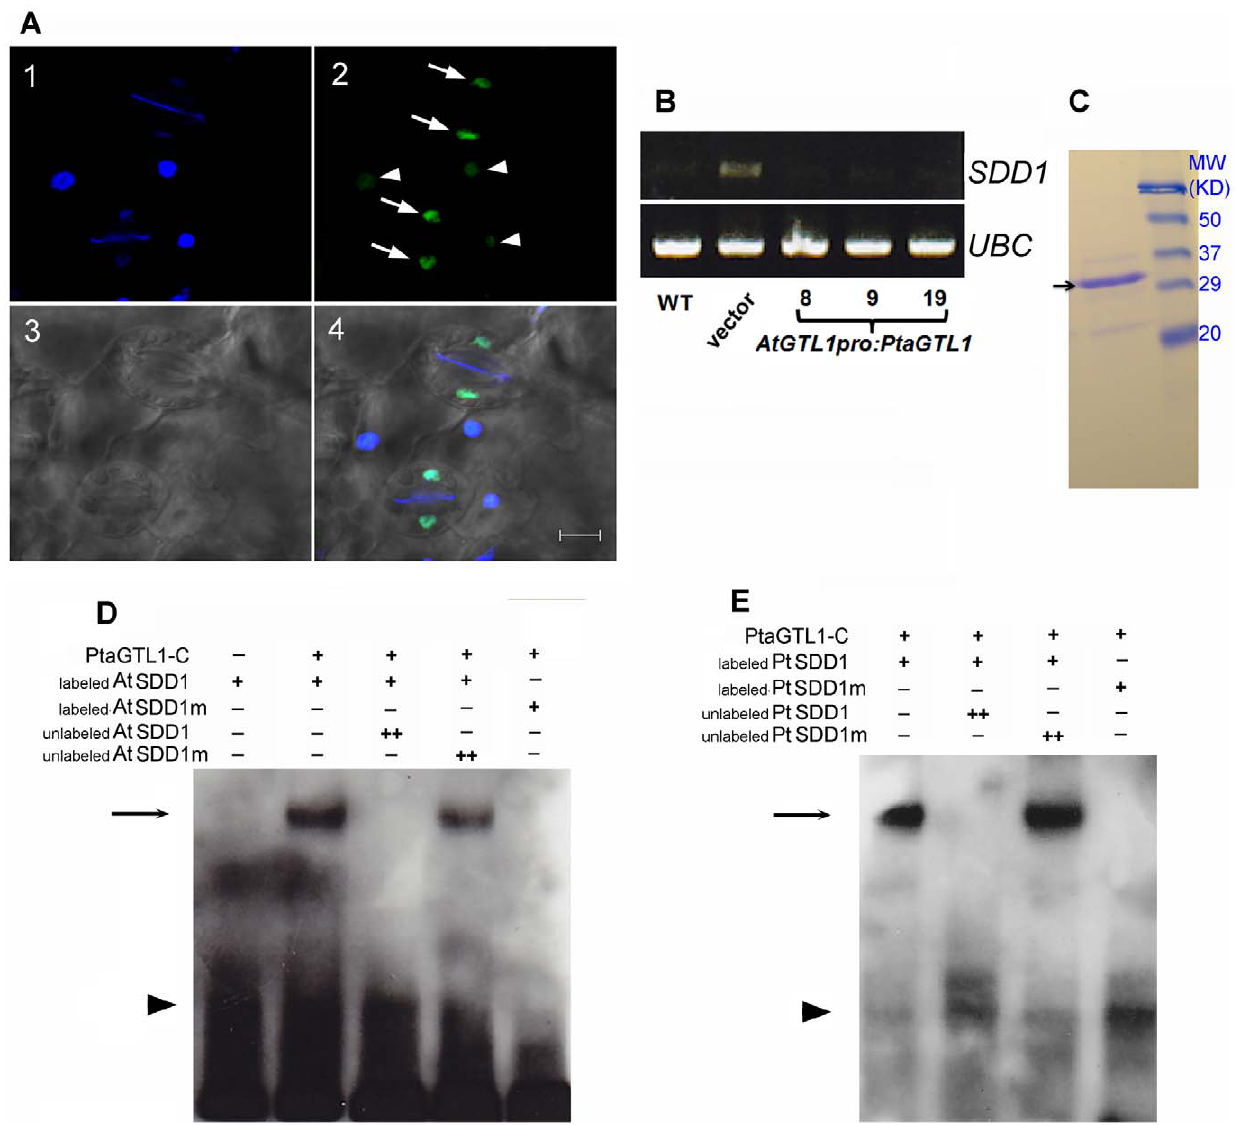
Figure 4. PtaGTL1 is localized to the nucleus, binds to a GT3 box-containing AtSDD1 promoter fragment, and trans-represses AtSDD1 expression. A. An abaxial epidermal layer of a one-week-old seedling leaf from a transgenic gtl1-4 plant expressing AtGTL1pro:PtaGTL1-GFP (line 9) was photographed with a confocal laser scanning microscope. Nuclei of guard cells (arrows) and pavement cells (arrowheads) were stained with DAPI (4 9 ,6-diamidino-2-phenylindole). 1, DAPI fluorescence, showing nuclear location; 2, GFP fluorescence, showing PtaGTL1 localization; 3, Light microscopic picture of the corresponding cells; 4, Panels 1, 2, and 3 merged. Bar equals 10 m m. B. SDD1 expression in fully expanded rosette leaves from 5-week-old plants (12-h diurnal photoperiod) was determined by RT-PCR. UBC was used as an internal control. C. Two micrograms of affinity purified 6 6 His-PtaGTL1-C was separated by SDS-PAGE (15% Tris-HCl gel). The arrow indicates the 6 6 His-PtaGTL1-C band (31 kDa), molecular markers are on the right. D. and E. PtaGTL1-C interaction with AtSDD1 and PtSDD1 promoter fragments require the GT3 and GT2 boxes, respectively. Recombinant 6 6 His-PtaGTL1-C was used in an EMSA with biotin-labeled DNA probes (200 ng, + ) corresponding to a fragment in the AtSDD1 promoter harboring the GT3 box (GGTAAA) (D) or a fragment in the PtSDD1 promoter harboring the GT2 box (GGTAAT) (E). Mutant versions of the SDD1 promoters (SDD1m), in which CC was substituted for GG in the GT3 ( AtSDD1 ) and GT2 ( PtSDD1 ) boxes, were used to test the necessity of the GT3 and GT2 boxes in the interaction. Unlabeled probes of both original and mutated DNA fragments (1000 ng, ++ ) were used as competitors to test the binding specificity. Arrows and arrow heads indicate the positions of protein-promoter probe complexes and free probes, respectively. doi:10.1371/journal.pone.0032925.g004 poplar drought tolerance and water use efficiency while main- taining yield. Since poplar is often cultivated under irrigated conditions, it is important that genotypes exhibit higher WUE at PtaGTL1 is predicted to have a CaM-binding site that is located soil water field capacity and low to moderate water deficit to in the first helix of the C-terminal DNA-binding domain minimize transpirational water loss. Both PtaGTL1 and PtaSDD1 (Figure 5A; http://calcium.uhnres.utoronto.ca/ctdb/). To deter- are loci for which allelic variation may lead to higher WUE with mine if PtaGTL1 interacts with CaM in vitro , purified PtaGTL1-C no or negligible reduction in biomass production.